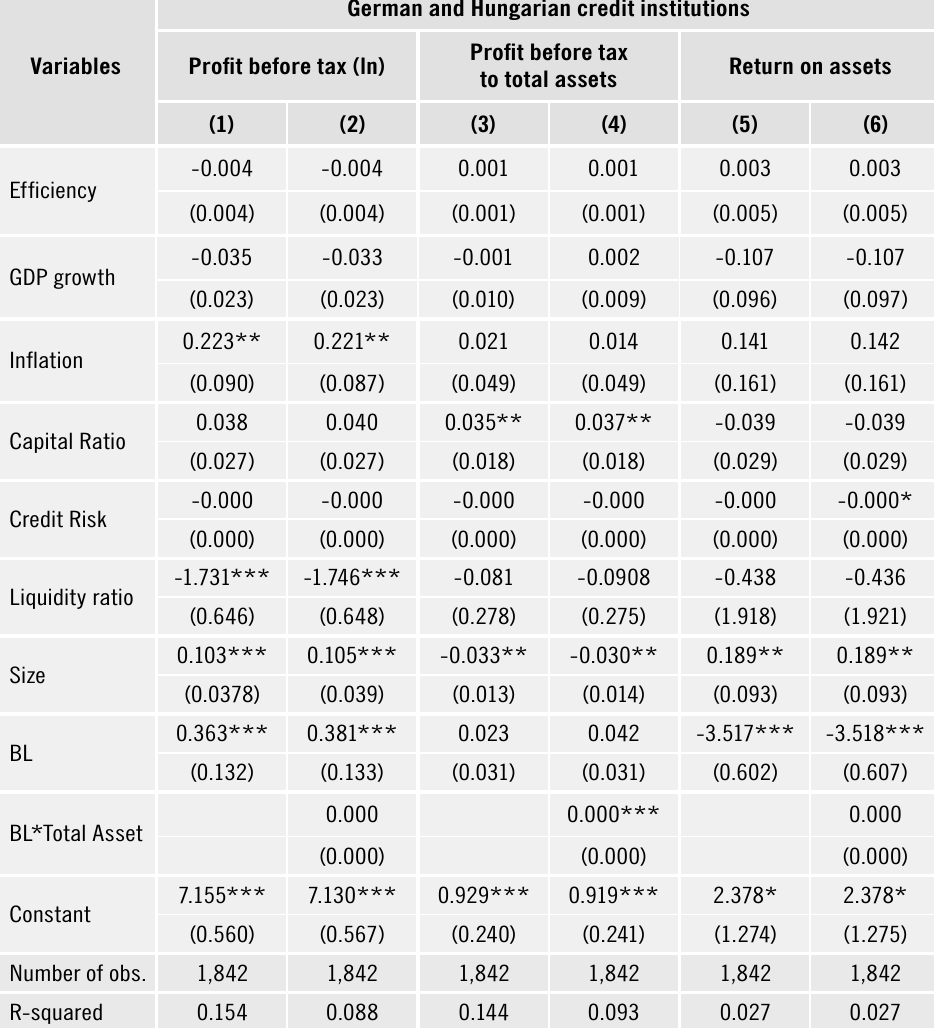
Table 3. Data presenting estimates based on GLS regressions with a random effect on German and Hungarian credit institutions in 2005–2015. Data has been sourced from unconsolidated financial statements. Institution-specific characteristics appear as one-year lagged variables. The bank levy (BL) is represented by a dummy variable indicating 1 for all years the levy applies to, and zero for all remaining years. Robust standard errors that control for clustering at the financial institution level are reported in